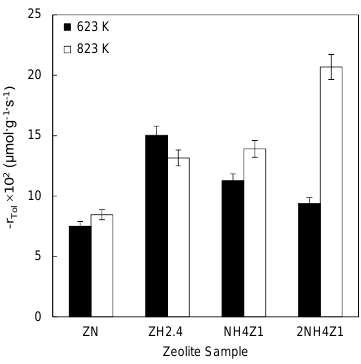
Figure 2. Effect of the physical-chemical characteristics of natural and modified zeolites on the toluene ozonation reaction rate. Experimental conditions were as follows: m sample = 150 mg; 101 kPa, 293 K; C Tin = 42.3 µmol·cm −3 ; C O3in = 3.57 µmol·dm −3 .